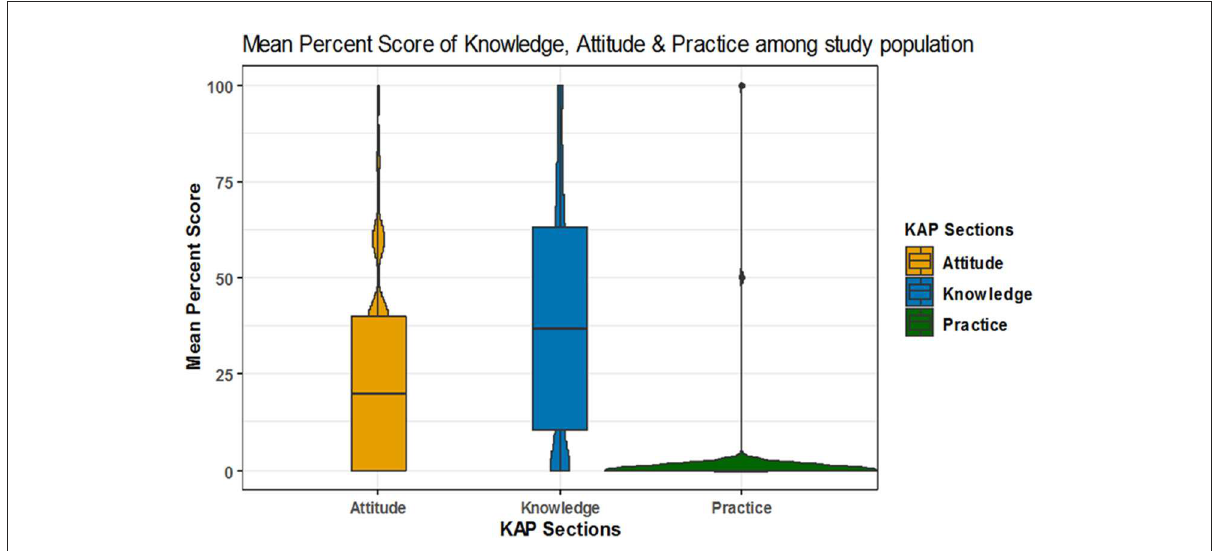
FIGURE2 Mean percent score of knowledge, attitude and